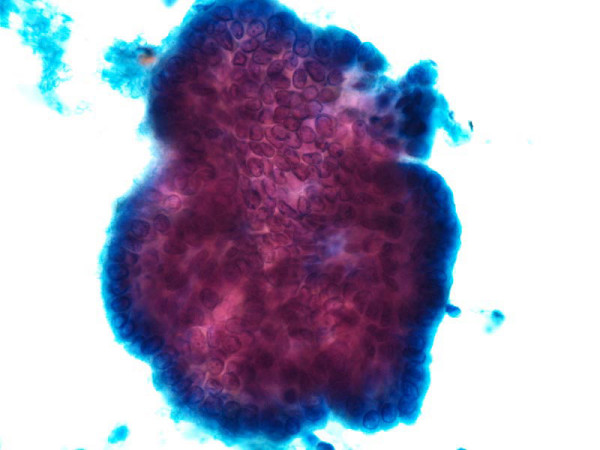
Papanicolaou-stained fine-needle aspiration smear from a lymph node showing metastatic papillary thyroid carcinoma.